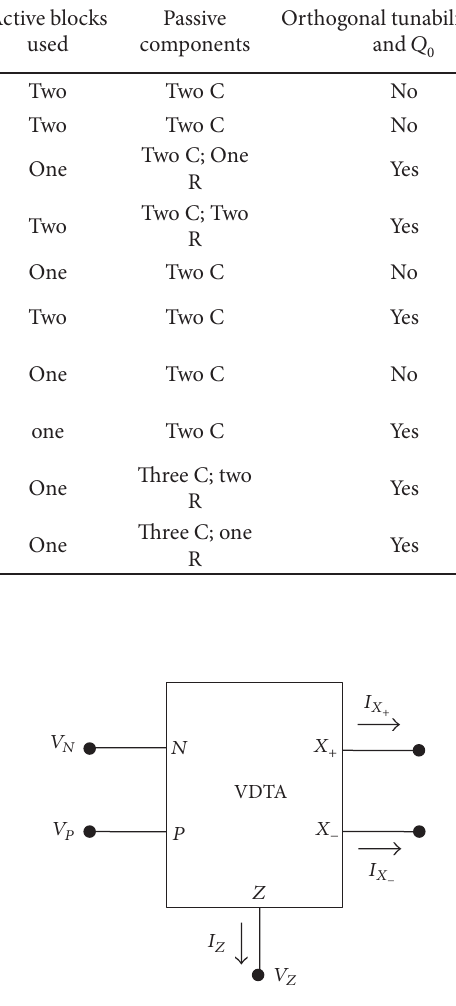
Figure 1: Circuit symbol of